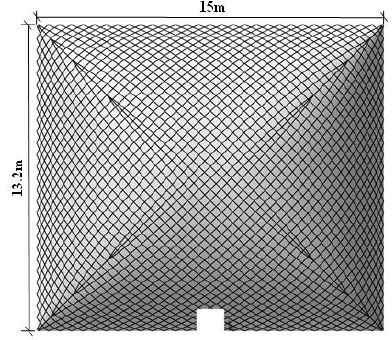
Figure 3. geometric